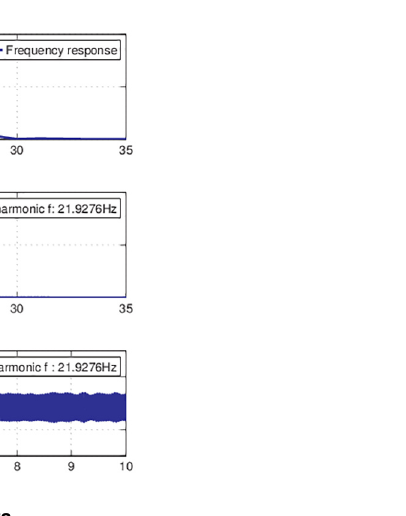
Fig 7. FIR filter frequency response and filtered